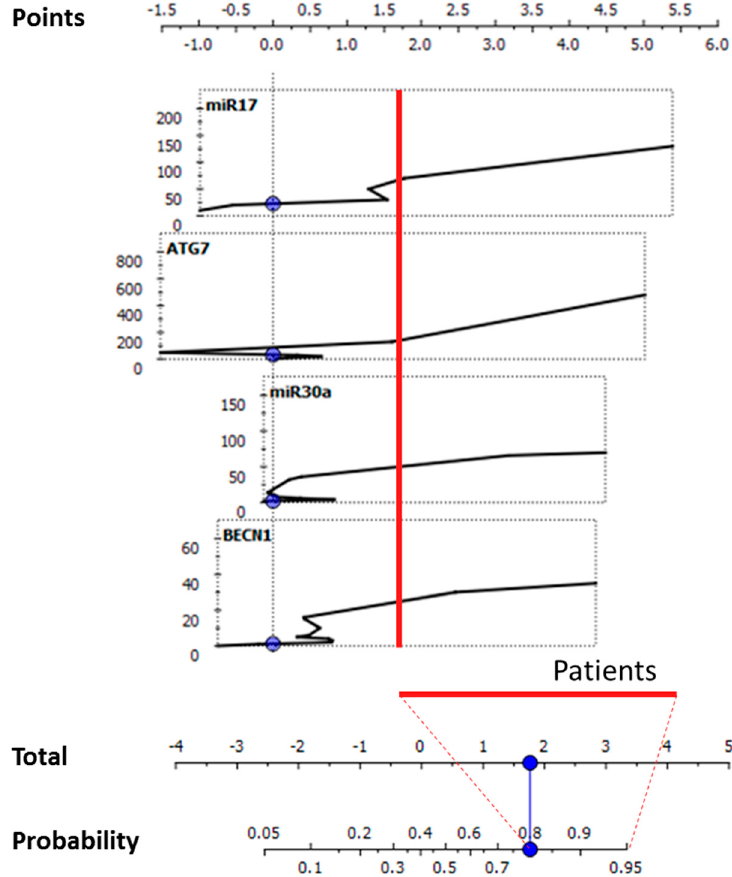
Figure 4. Nomogram tool to predict CD status in the blood specimens. The nomogram (lower graph) was created considering the relative quantitative expression values of the analyzed genes/miRNAs (upper graphs). The red line evidences the portion of the curves (on the right side of each) that confers a high probability ( p > 0.8) to correctly classify a CD condition.